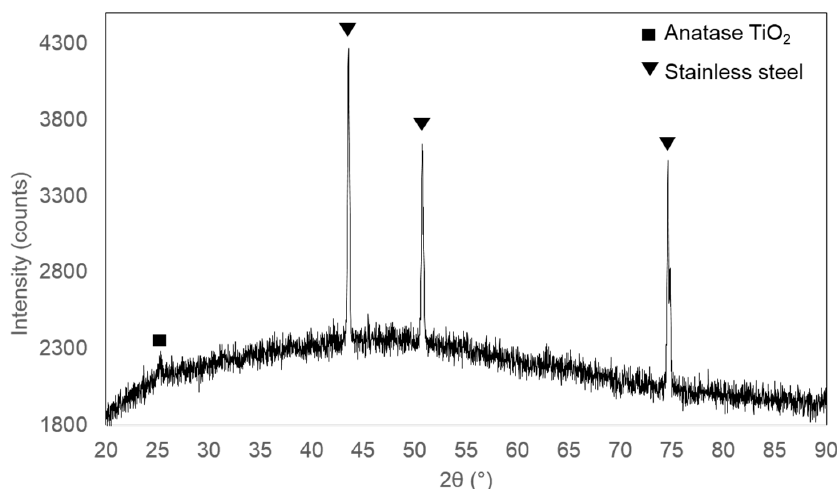
Figure 4. XRD pattern of TiO 2 coated on stainless steel by Spray-ILGAR technique using 6.83 mM of titanium diisopropoxide bis(acetylacetone) alcoholic solution and heated at 460 °C. The photocatalytic results of the samples using different concentrations of TiO 2 precursor, different heating temperature and different duration of spraying time are summarized in Table 2.